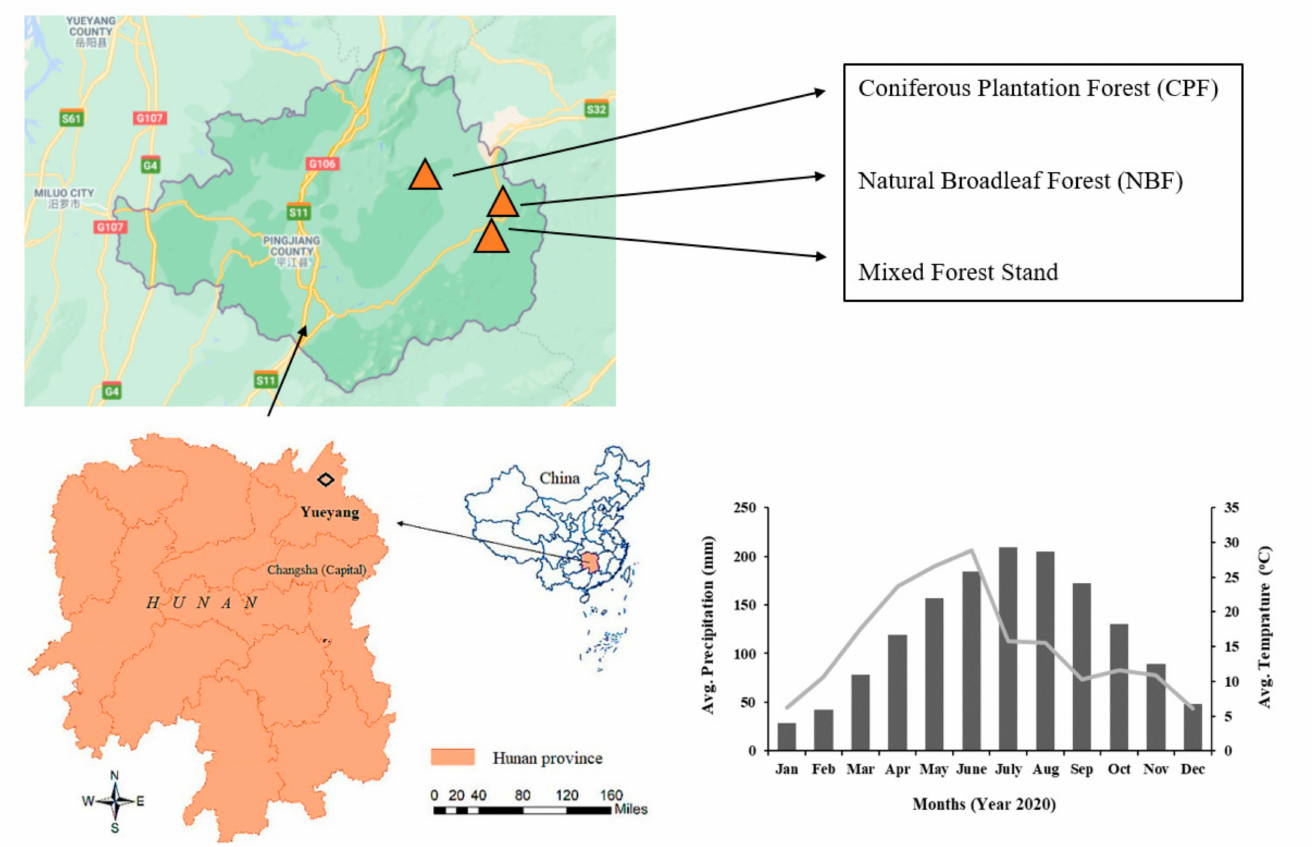
Figure 1. Location and climatic conditions of the study